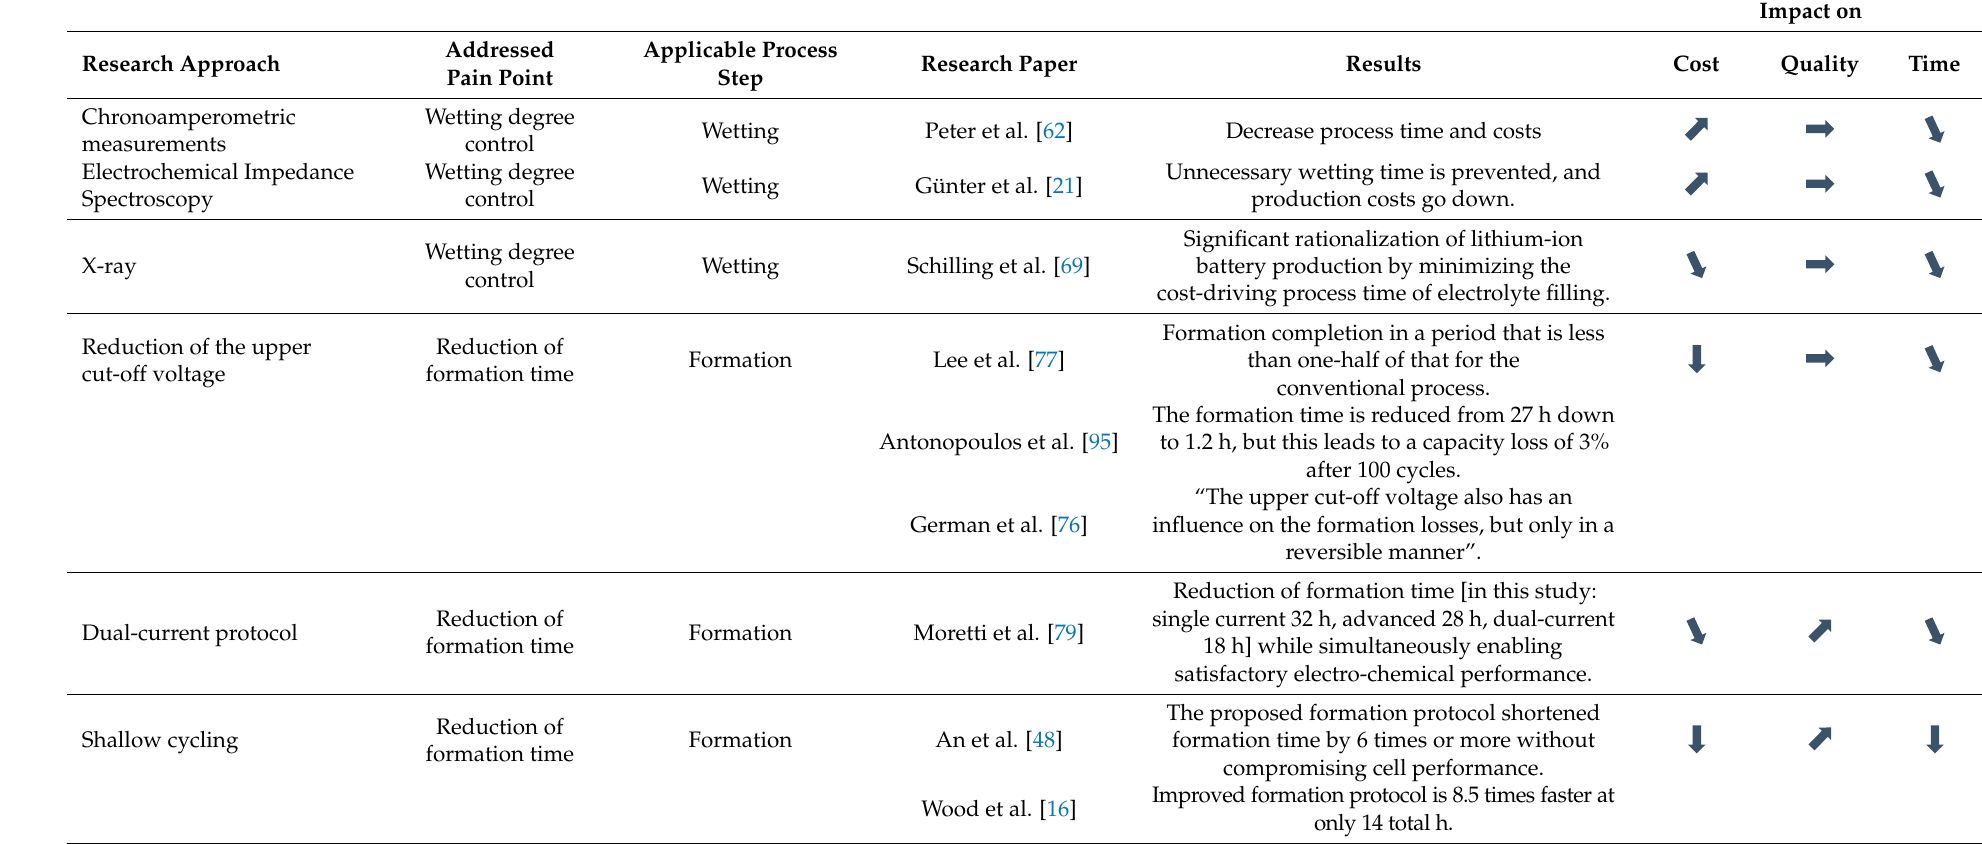
Table 1. Research solution.